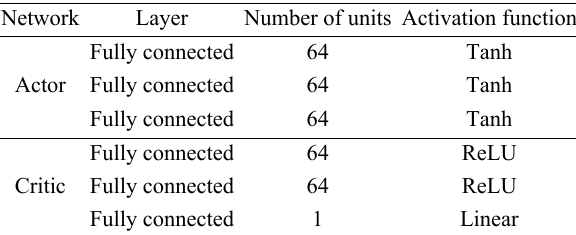
Table 1 Structures of actor and critic network.